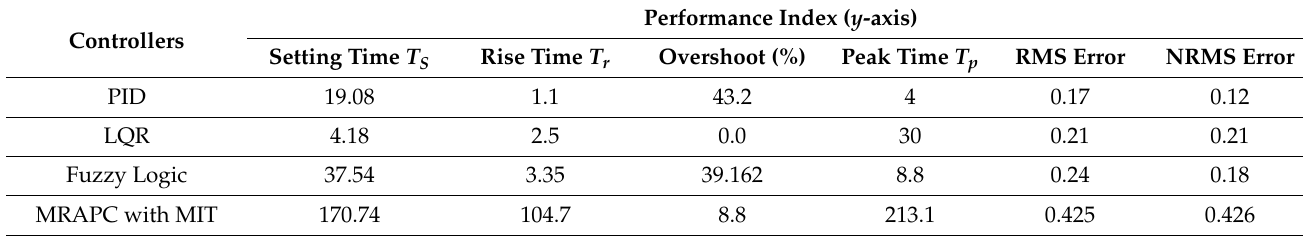
Table 7. Performance comparison of all controllers for the lateral position ( Y -axis).